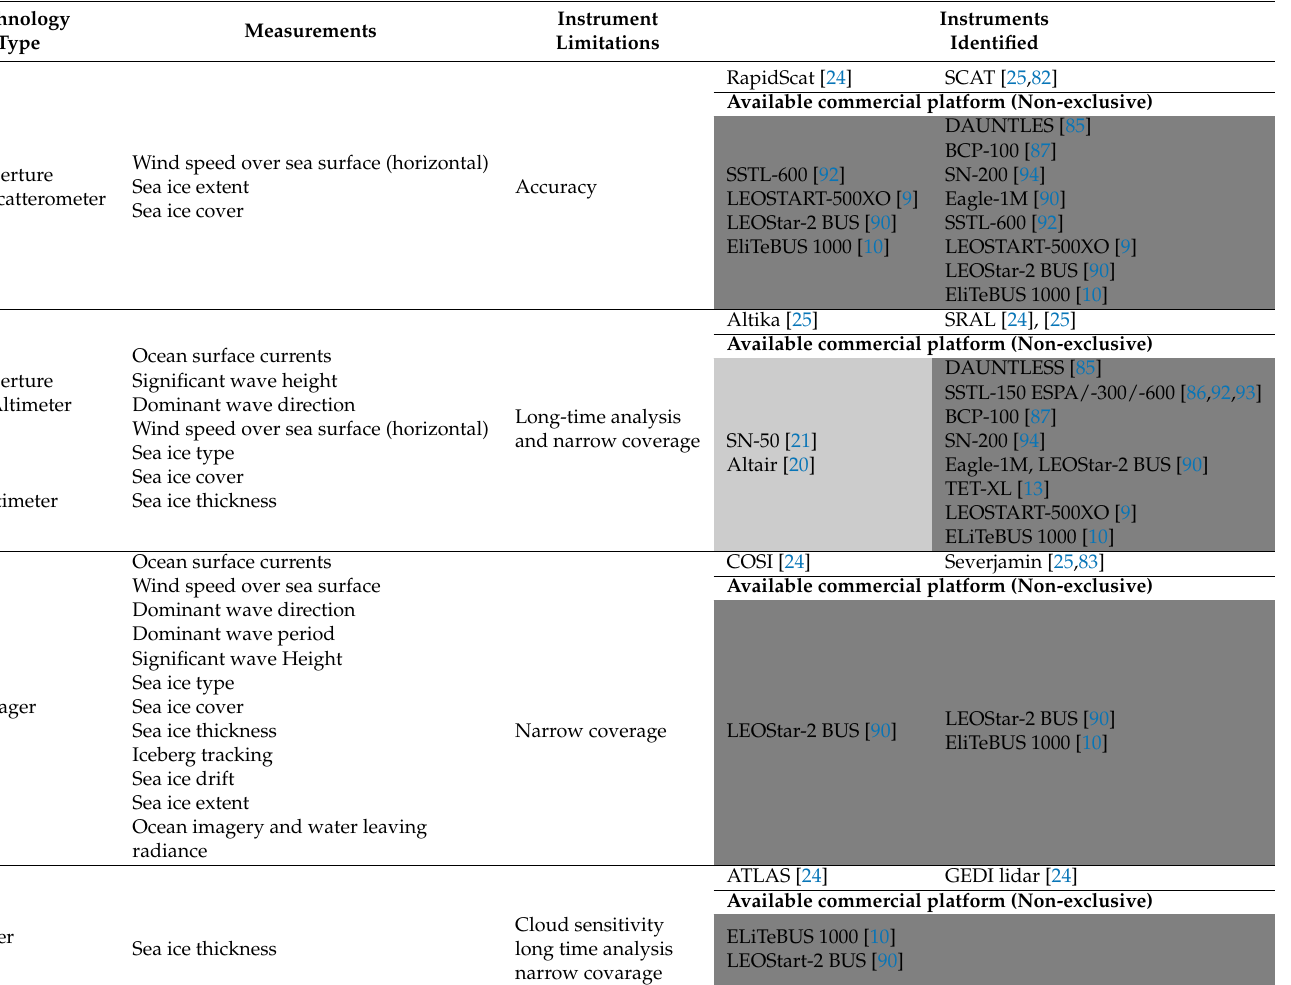
Table 7. Mapping of potential active sensors and platforms to meet the user